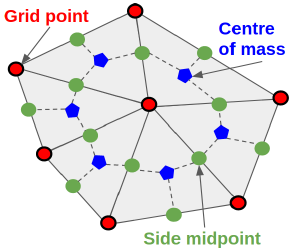
Figure 1. Sketch of the triangular grid on the sphere – grid or data points (red circle with black contour), triangle centre of mass (blue pentagon), and side midpoints (green